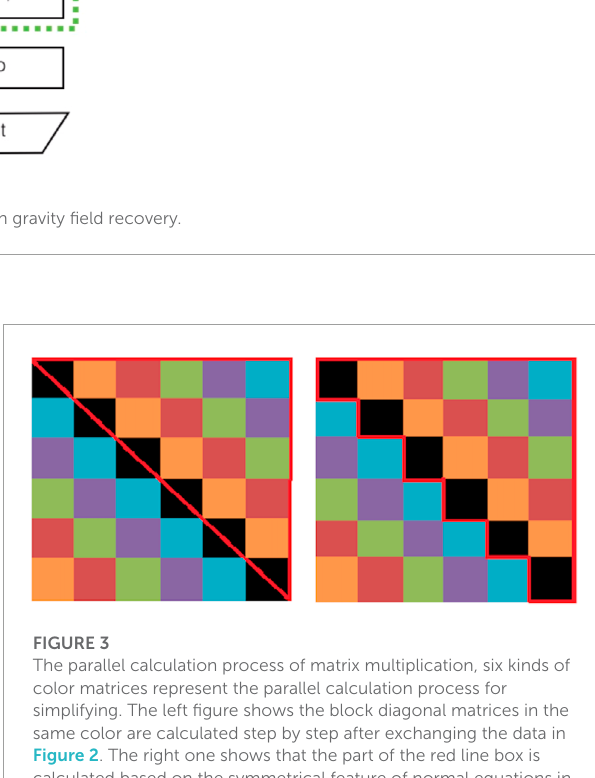
in a parallel way which is shown in the green dotted line box of Figure 1 . We use the Gauss-Jordan elimination method, which is suitable for inverting both symmetric and asymmetric matrices, and program it in FORTRAN language, where arrays are stored by column priority. The Gauss-Jordan elimination method with column exchange is used with a parallel algorithm, as described by previous studies (Melhem, 1987; Chen et al., 2004; Markus, 2012). To implement the parallel calculation, we divide the columns of the matrix and use the main columns in a queue to perform